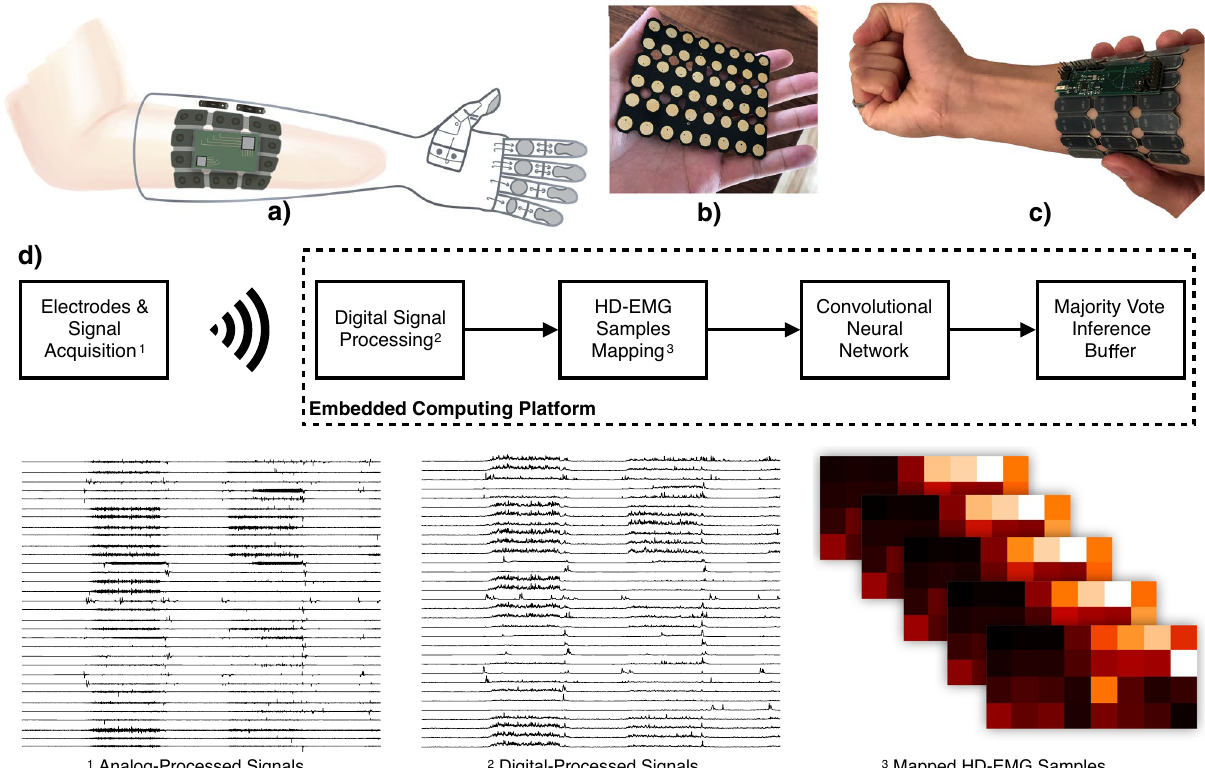
Figure 1. Prosthesis system concept and hardware components. ( a ) Integrated hand prosthesis concept. ( b, c ) Bottom and top view of the electrodes array and the data acquisition platform. ( d ) Block diagram of the myoelectric prosthesis control solution. The user’s voluntary muscle contractions are sensed by a 32-channel high-density electrode array. After analog filtering and analog-to-digital conversion, the signals are sent through a wireless link to the computing platform. The signals are then processed by a mean absolute value (MAV) filter and the samples from each channels are mapped into 4x8 matrices. The resulting muscle activation maps are fed into the convolutional neural network and the inference results are stored in a buffer from which a majority vote is extracted to provide the final gesture recognition output. Drawing in ( a ) was produced by Agence IMPAKT Scientifik Inc. following specifications from the